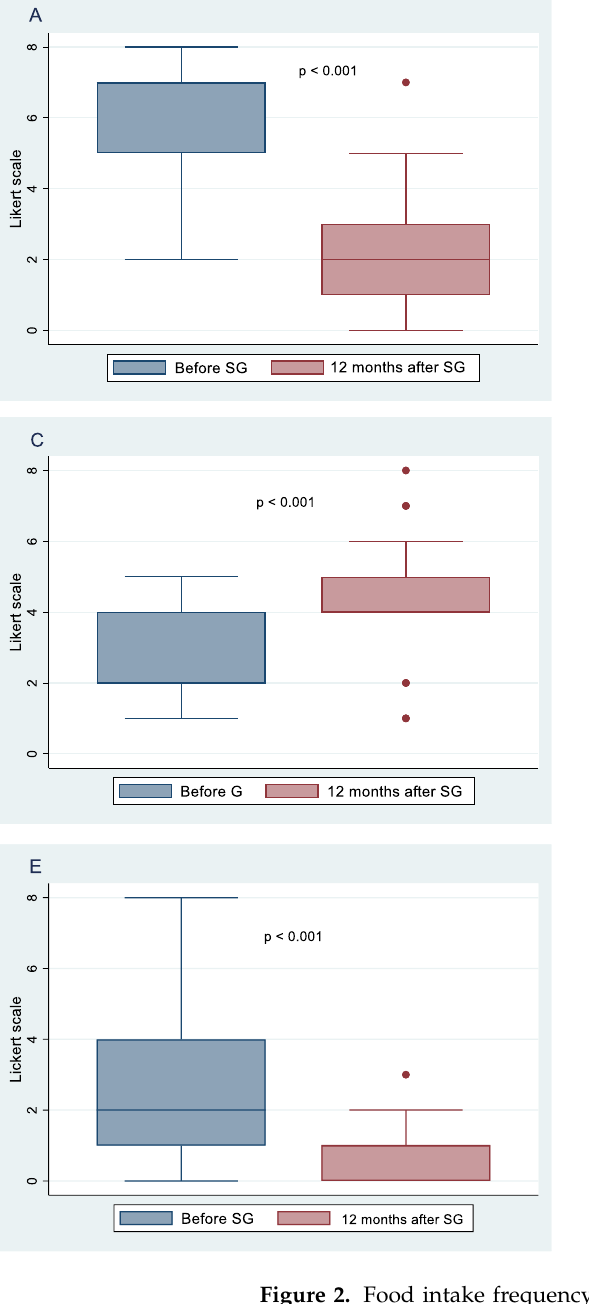
Figure 2. Food intake frequency before sleeve gastrectomy (SG) and after 10 months follow-up. Change in the frequency of sweet and snacks in females ( A ), and males ( B ); change in the frequency of vegetables and fruits consumption in females ( C ), and males ( D ); change in the frequency of soft drinks consumption in females ( E ), and males ( F ).